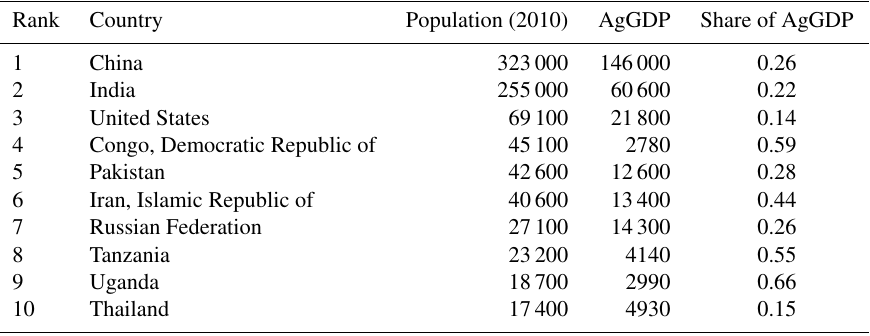
Table B3. Top 10 countries of 2010 population (thousands) exposed to dry areas with agricultural GDP (millions of USD) and share of agricultural